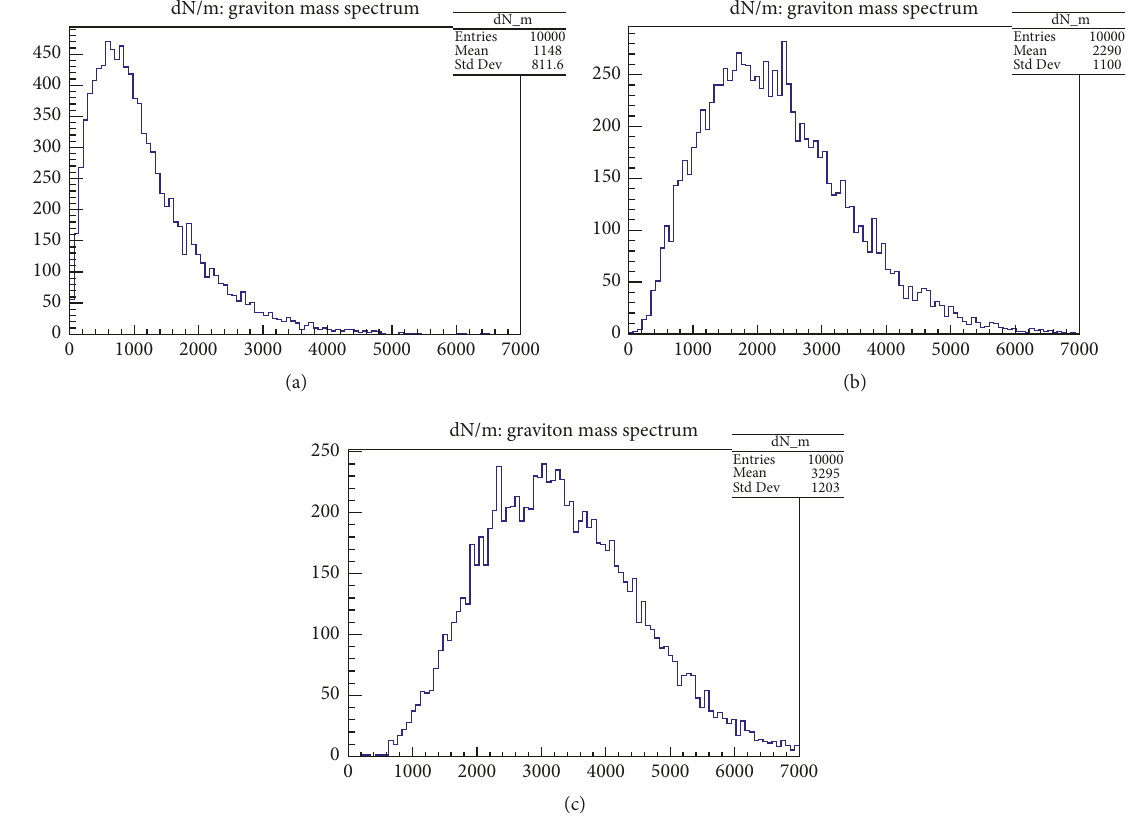
Figure 6: Graviton mass spectrum within monojet LED model for G jet emission process gg → 𝐺𝑔 for (a) 𝑛 = 2 , (b) 𝑛 = 4 , and (c) 𝑛 = 6 at the center of mass energies of 14 TeV.